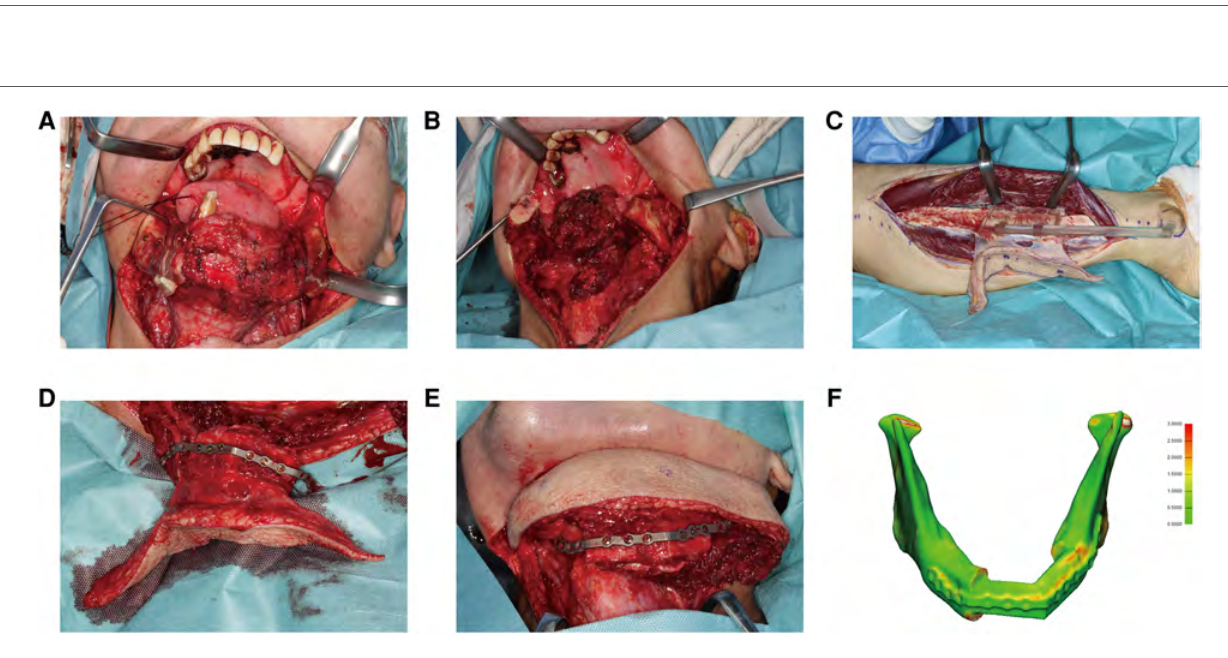
FIGURE 7 A 67-year-old male presented with squamous cell carcinoma at the tongue and left mandible. ( A ) 3D-printed cutting guides fi tted onto the mandible as planned. ( B ) The mandible defect was shown after glossectomy and segmental mandibulectomy. ( C ) The fi bula free fl ap was harvested with the cutting guide. ( D ) The PSSP was fi xed onto fi bular segments with corresponding screw holes. ( E ) The “ fi bula-plate ” was transferred to the defect site and fi xed to corresponding screw holes in the mandibular stumps. ( F ) The reconstructed mandible was superimposed onto the virtually designed mandible. The spatial deviation was visualized with a color map. The absolute distance deviation was 0.57±0.46